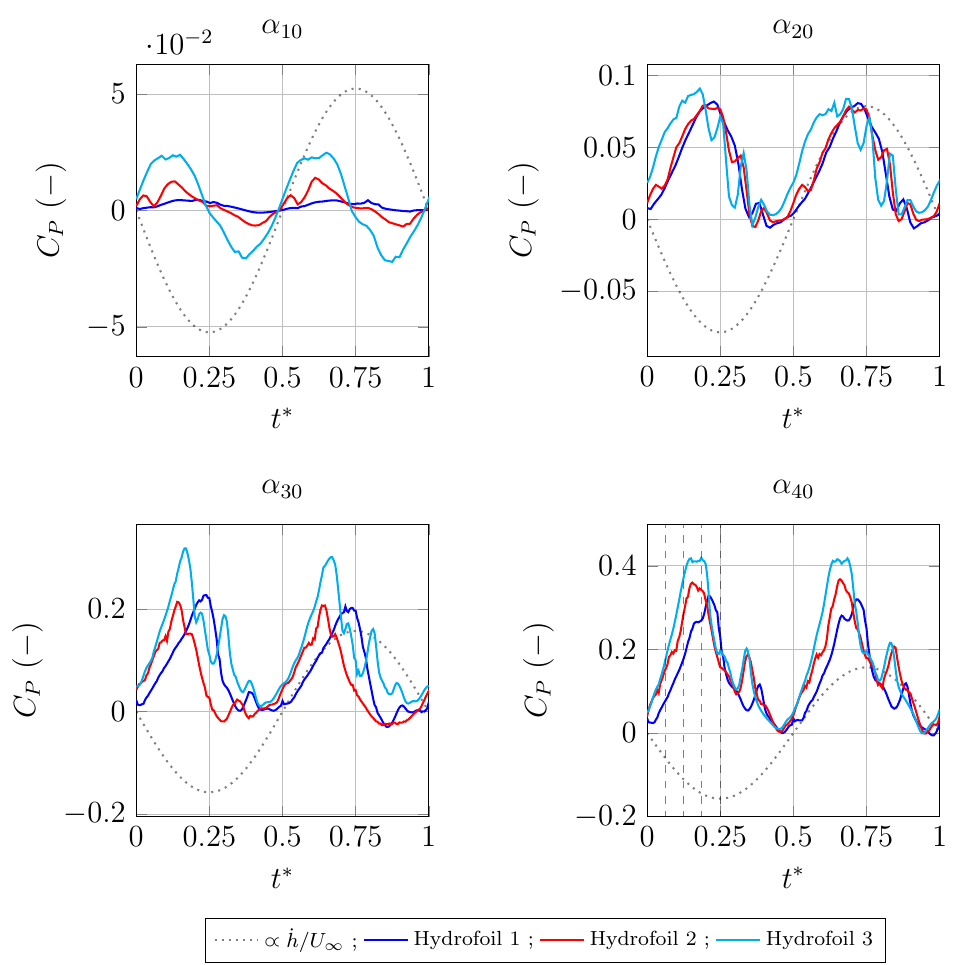
Figure 10. Power coefficient C P and hydrofoil vertical velocity ˙ h / U ∞ versus time, for α 10 to α 40 , f ∗ = 0.025, ∆ h = 0.8 m, and for three